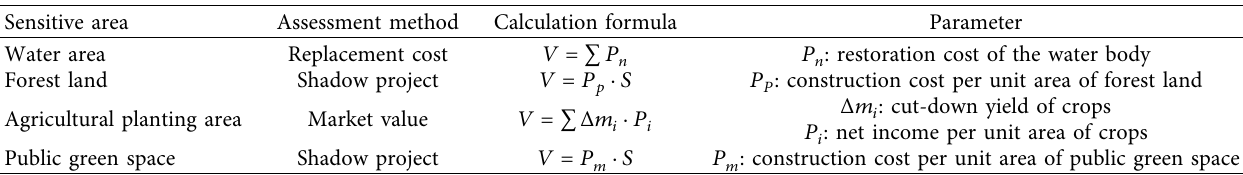
Table 5: Assessment methods of value loss for different environmental sensitive areas.